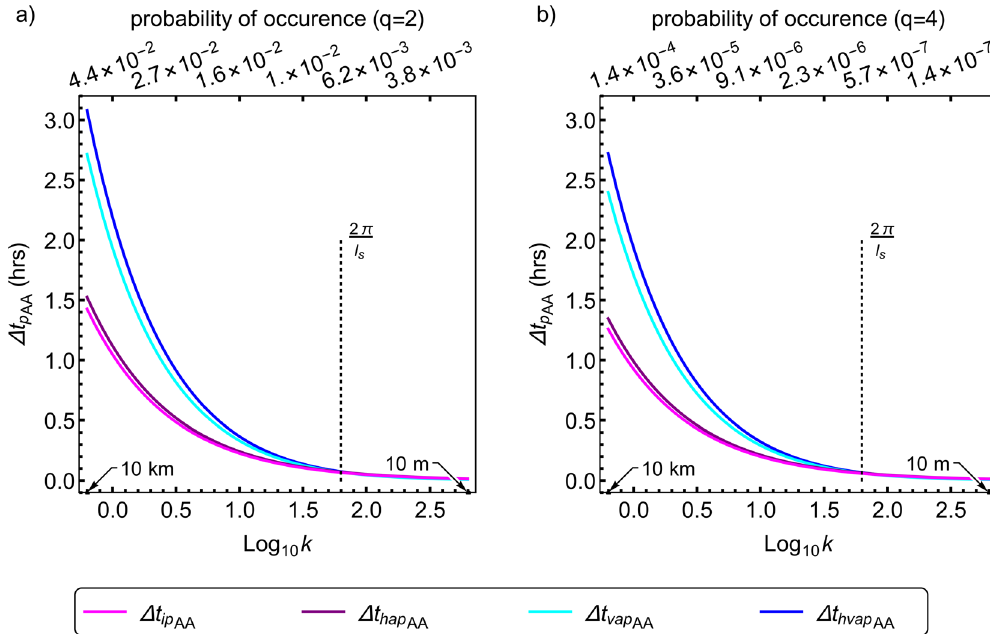
Figure 3. Angular averaged theoretical predictability limits of spatially isotropic and anisotropic (with 100 m sphero-scale) horizontal wind fields. The wind field has multifractal parameters α = . = . = . C H 1 5, 0 15, 0 33, and anisotropy parameters, as discussed in the text. The subscripts 1 ip , hap , vap , hvap denote isotropic, horizontally anisotropic, vertically anisotropic, horizontally and vertically anisotropic cases, whereas the subscript AA indicates angular averaging. While the angular averaged predictability limits is in hours, the wavenumber k is in km − 1 and corresponds to scales ranging from 10 m to 10 km. The two panels differ only by the order of autocorrelation q used in deriving the predictability limits. ( a ) spectra based angular averaged predictability limits ( q = 2) as a function of logarithmic wavenumber. The probability of occurrence shows the probability distribution of energy fluxes above the scaling threshold ( λ γ q , where λ